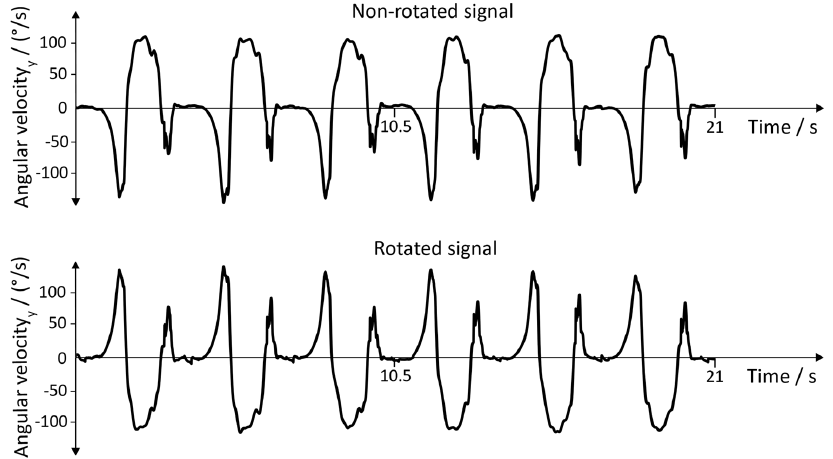
→ y . Position of the sensor: inside of the axis